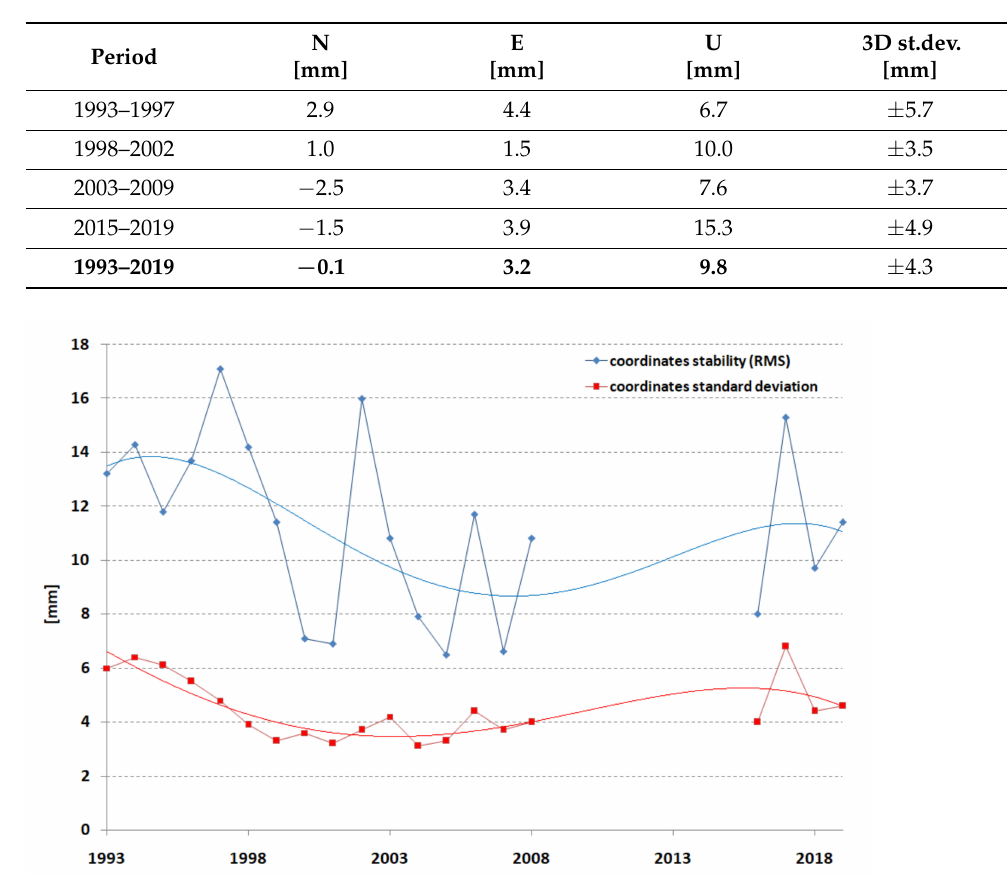
Figure 10. Borowiec SLR station—coordinate stability (blue) and coordinate standard deviations (red) for annual periods in